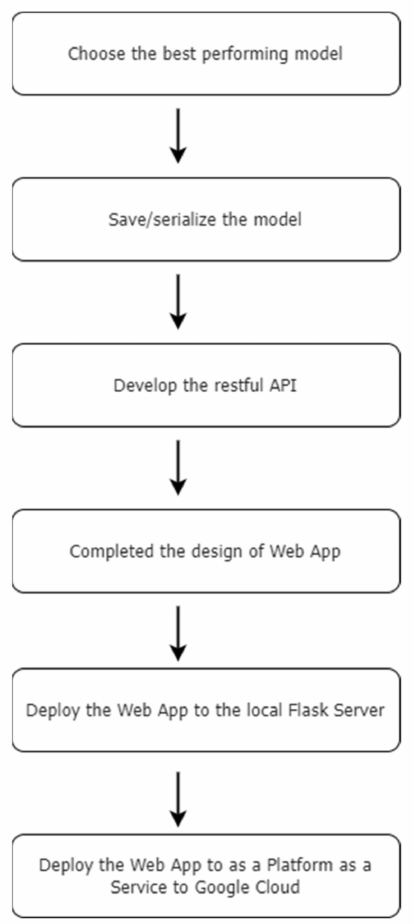
Figure 10. Steps involved in design and deployment of the crop recommendation